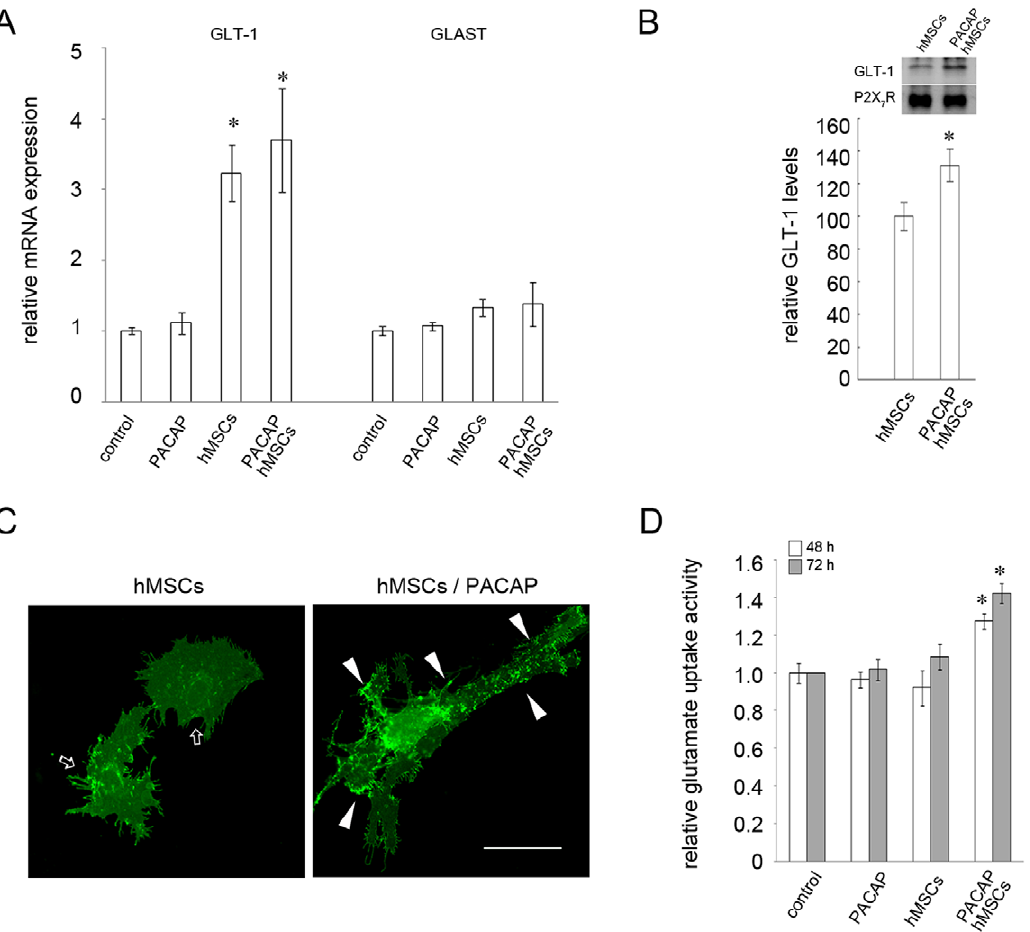
Figure 7. GLT-1 production and glutamate uptake ability of astrocytes promoted by combinatorial treatment with PACAP and hMSCs. (A). Astrocytes were treated with PACAP (20 ng/ml), or indirectly co-cultured with hMSCs in the absence and presence of PACAP (20 ng/ml) for 48 hours. The cultures were subjected to Q-PCR for measurement of the mRNA levels of GLT-1 and GLAST. Data are presented as mean 6 SEM and expressed as the ratio of GLT-1 (GLAST) mRNA levels compared to control. * p , 0.05 versus control. (B). Astrocytes were indirectly co-cultured with hMSCs in the absence or presence of PACAP for 48 hours. Membrane proteins were then extracted for western blotting using anti-GLT-1 antibody. The same blot was reprobed with anti-P2X 7 R antibody. P2X 7 R levels are presented as a loading control. Relative intensity of GLT-1 levels normalized to P2X 7 R was measured. Data are presented as mean 6 SEM and expressed as a percentage of GLT-1 levels in the group with combinatorial treatment compared to that detected in the group co-cultured only with hMSCs. * p , 0.05 versus the group only co-cultured with hMSCs. (C). Astrocytes were infected by lentivirus carrying lenti-GLT-1-GFP, and then co-cultured with hMSCs in the absence or presence of PACAP. Strong punctate fluorescence spots (arrowheads) were observed in the processes of astrocytes co-cultured with hMSCs in the presence of PACAP, when compared to that seen in astrocytes co-cultured only with hMSCs (arrows). Scale bar, 50 m m. (D). Astrocytes were treated with PACAP, or co-cultured with hMSCs in the absence or presence of PACAP. After 48 or 72 hours, the cultures were subjected to [ 3 H]-L-glutamate uptake analysis as described in Materials and Methods. Data are presented as mean 6 SEM and expressed as a ratio of the glutamate uptake in each treated group compared to that detected in the control group. * p , 0.05 versus